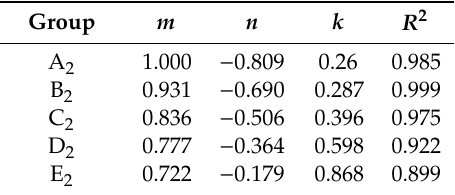
Figure 15. The relationship between oil replacement correction factor and aging time after oil replacement. Table 7. The fitting results of each